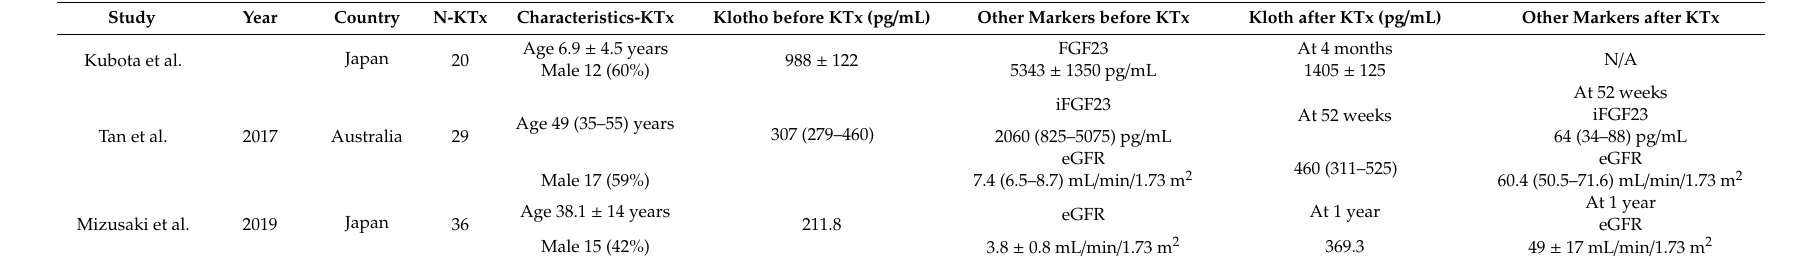
Table 1. Characteristics of the included studies assessing serum klotho after kidney transplantation.